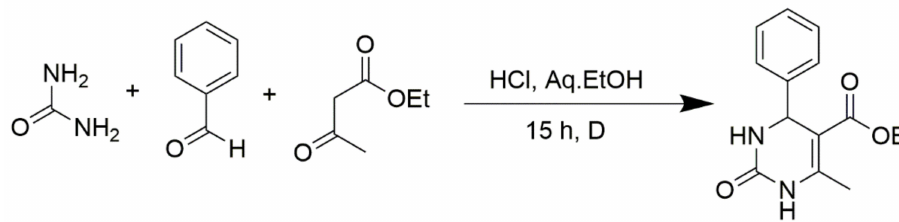
Scheme 1. Classic Biginelli reaction